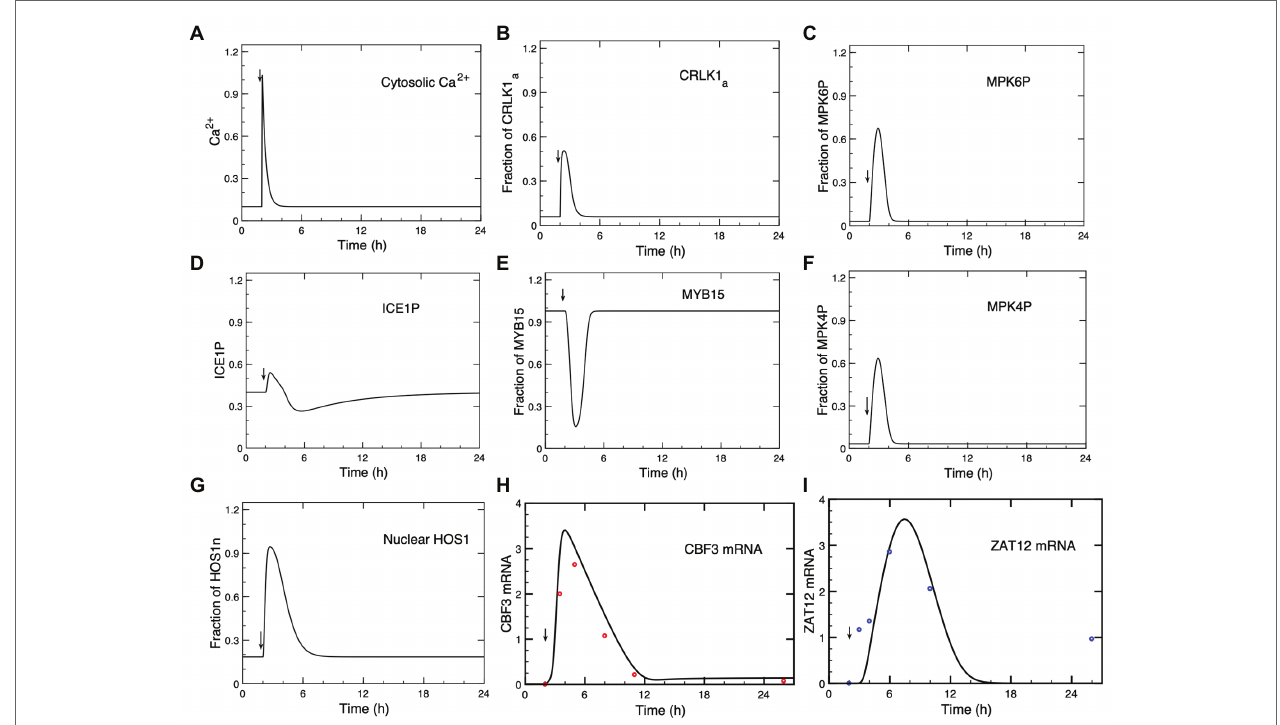
FIGURE 2 | Dynamics of the cold response pathway after a cold stress. (A) The cold stress produces a transient increase in Ca 2+ at time = 2 h. This brief Ca 2+ pulse induces a transient change in the successive steps of the cascade: CRLK1a (B) , MPK6P (C) , ICE1P (D) , MYB15 (E) , MPK4P (F) , HOS1n (G) , CBF3 mRNA (H) , and ZAT12 mRNA (I) . (H,I) Comparison of theoretical predictions (solid lines) for the time course of CBF3 mRNA and ZAT12 mRNA with experimental data for CBF3 (red dots) and ZAT12 (blue dots) redrawn, respectively, from Figure 1 in Zarka et al. (2003) and from Figure 7A in Fowler and Thomashow (2002), by means of the software ImageJ for Image Processing and Analysis (https://imagej.nih.gov/ij/). Time is increased by 2 h when redrawing the experimental points from the original publications, because in the simulations the cold stress is given at time = 2 h (to determine the steady-state levels before the cold signal is applied) instead of 0 h in the experiments. The results are obtained by numerical integration of kinetic equations (4)–(17), by means of the program XPP (http://www.math.pitt. edu/~bard/xpp/xpp.html), for a Ca 2+ pulse generated according to eqs. (1a–c), while the associated changes in the fraction of activated calmodulin (CaM) are determined according to eq. (3), as described in Sections 1 and 2 in Supplementary Material . Parameters are defined in Supplementary Table 2 where their numerical values are